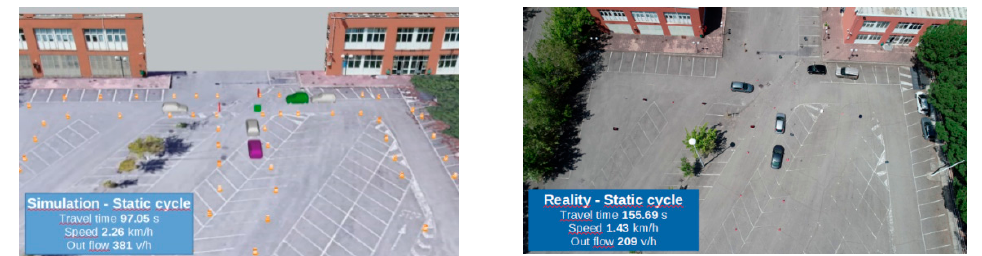
Figure 9. Simulation and experimental results of static cycle.